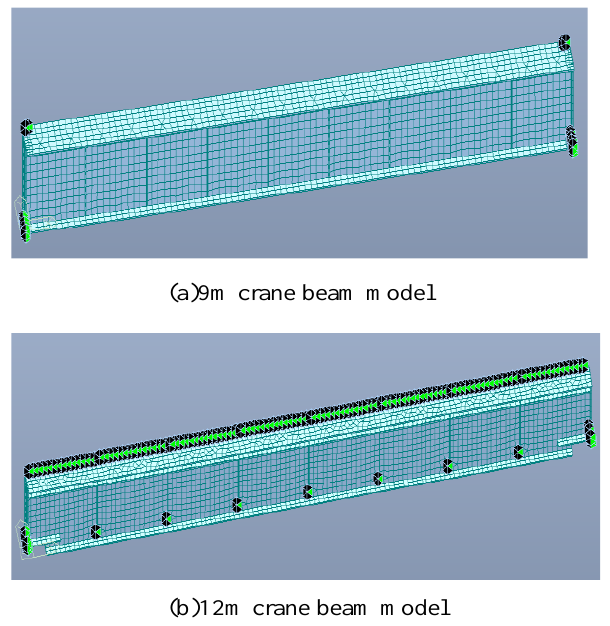
Figure 2. Midas finite element model of crane beam.